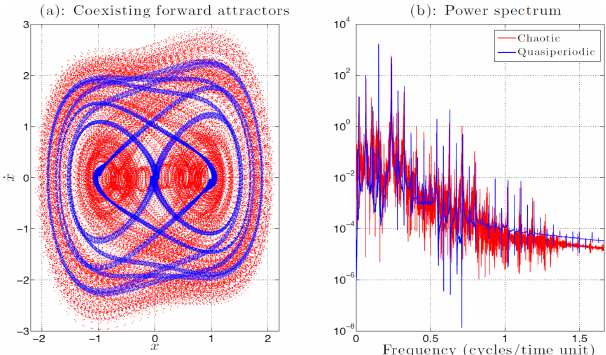
Figure A1. Coexistence of local forward attractors. (a) Quasiperi- odic forward attractor (blue) and chaotic attractor (red). (b) Power spectrum associated with the quasiperiodic orbit (blue) and the chaotic one (red).